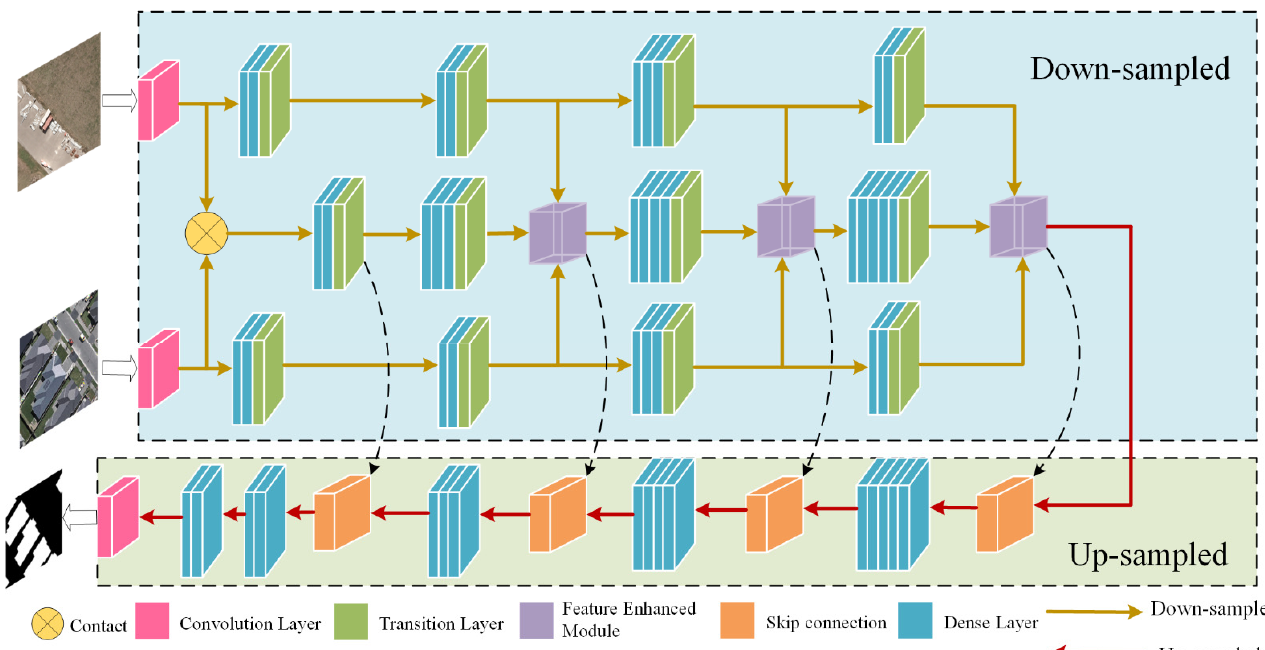
Figure 1. MDEFNET network structure.